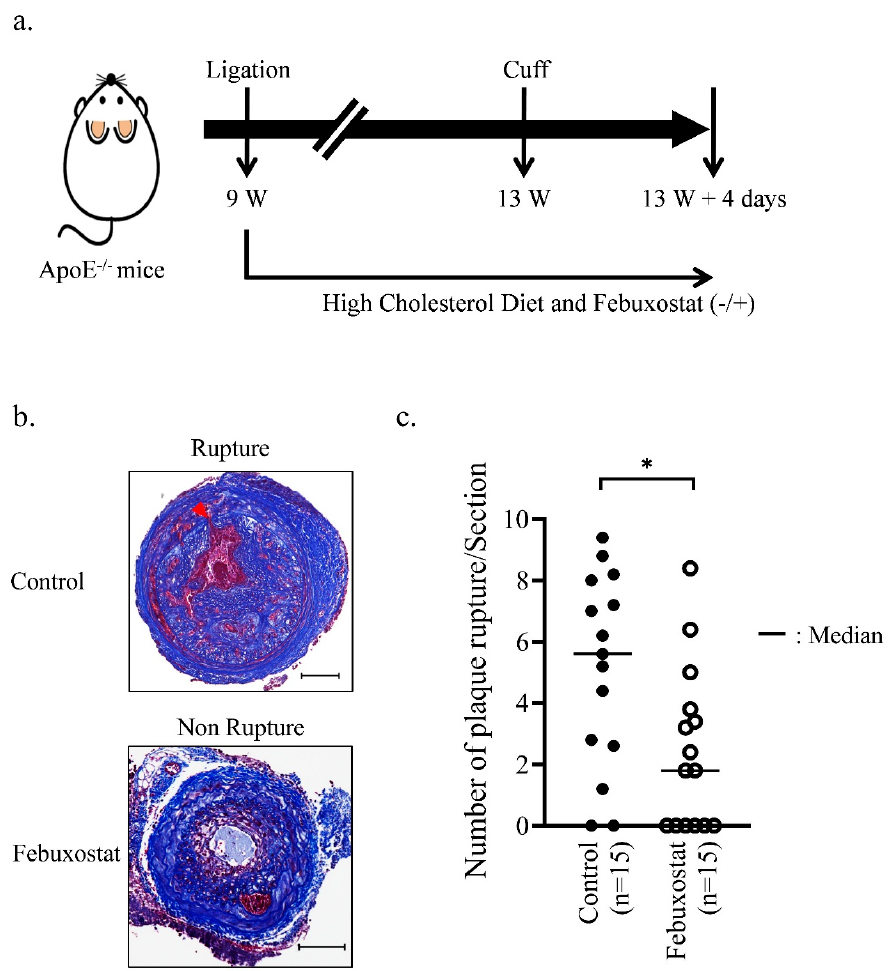
Figure 5. Febuxostat treatment reduces rupture events of the common carotid artery. ( a ) Schematic diagram of the operation for the atherosclerotic plaque rupture model. After the carotid artery